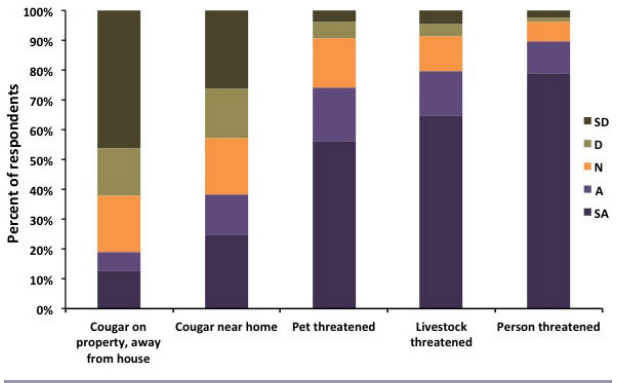
Fig. 2 . The tolerance of survey respondents to cougar-human interaction scenarios. Respondents were asked how much they agreed that shooting a cougar would be the appropriate course of action for each scenario. SA = strongly agree, A = agree, N = neutral, D = disagree, SD = strongly disagree.